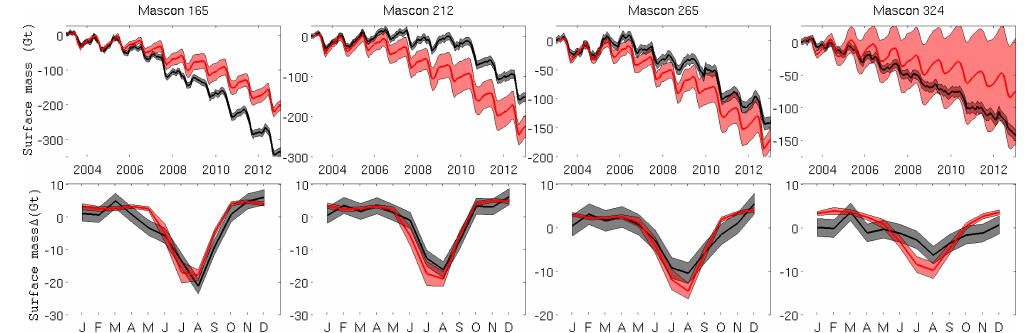
Figure 8. Southwest Greenland (top row panels) cumulative surface mass and (bottom row panels) a 2003 to 2012 climatology of surface mass change comparing GRACE_JPL (black) and ISSM_GrIS+P (red) with 1 σ uncertainties displayed. (See Sect. 5 for details on calculation of errors and uncertainties.)